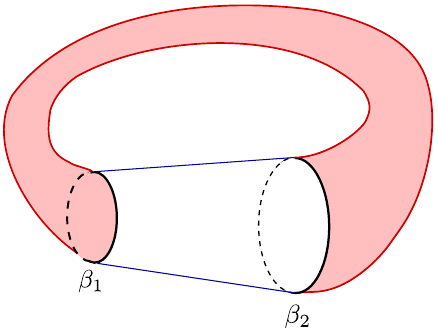
Figure 7. Schematic of the wormhole phase. The asymmetry of the wormhole is caused by the different sizes of the thermal circles which are glued to the regulated AdS ingly, the two boundary regulators are